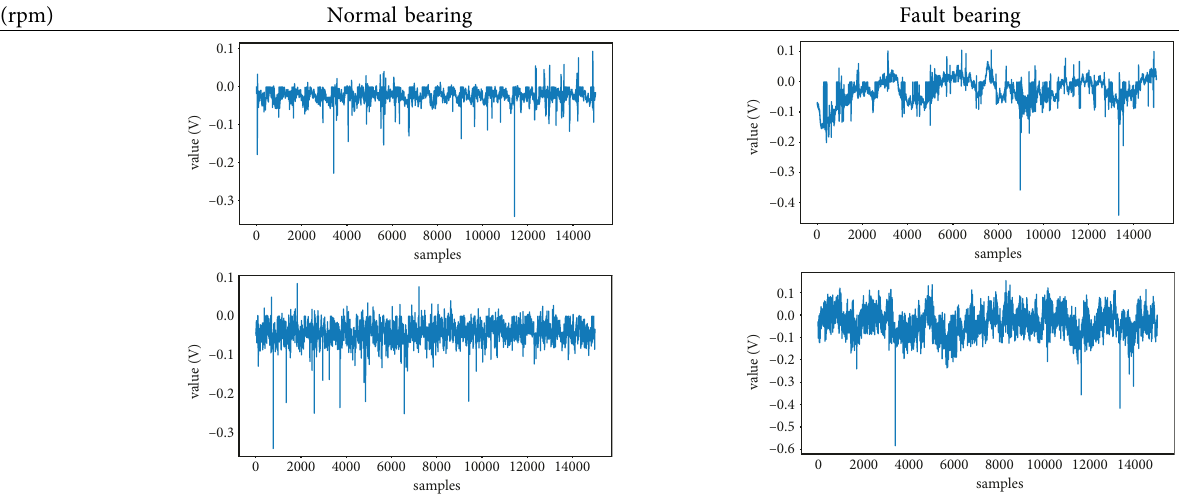
Table 6: Time domain diagram of acoustic